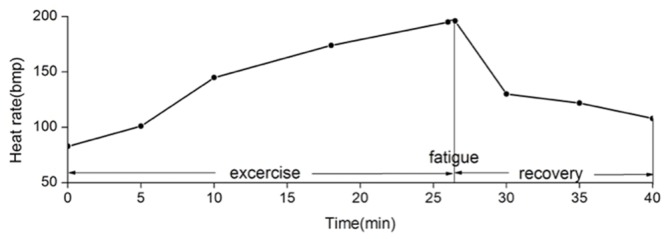
Mean heart rate changes during and after exhaustive exercise. We define that the state of motor fatigue is the time point when the participant cannot maintain the cadence, and when heart rate arrives 90% of the maximum heart rate. In this experiment, participants reach the fatigue state after 26 min of exhaustive exercise in average.